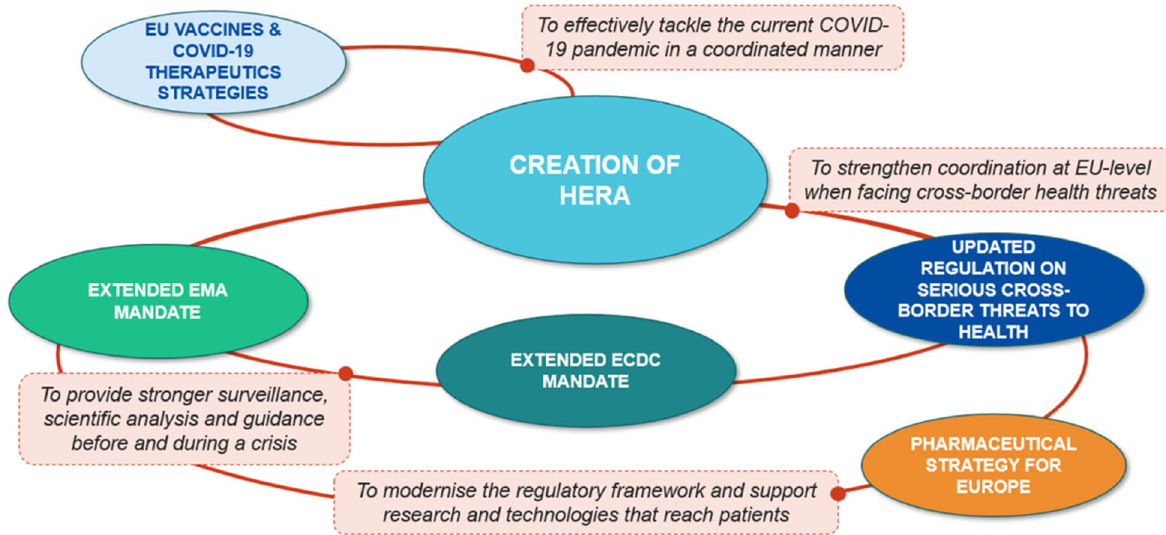
Fig. 3 HERA aims to reinforce the global health emergency preparedness and response